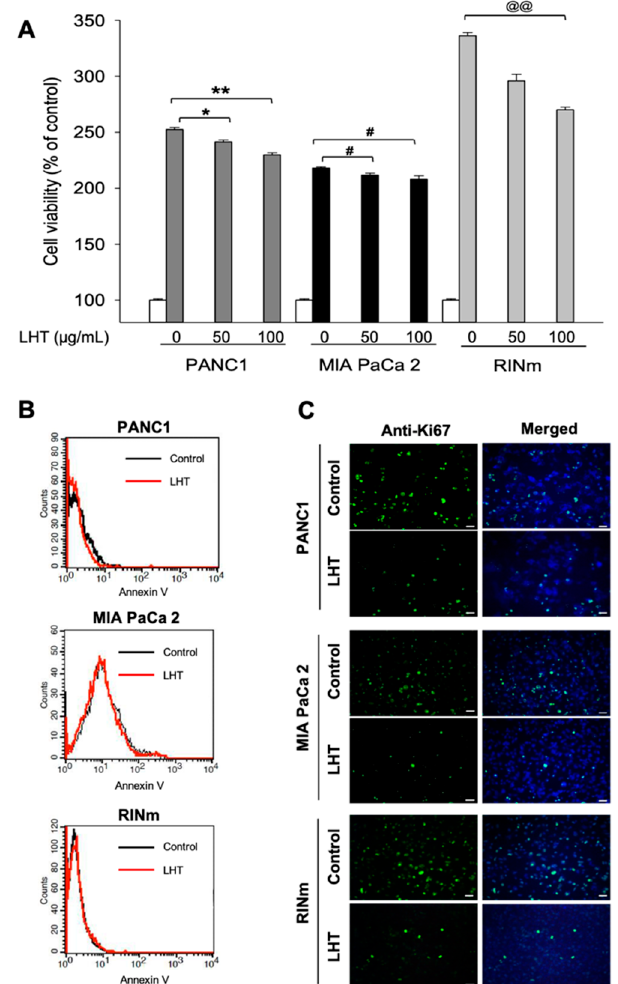
Figure 1. Proliferation inhibition of different types of pancreatic cancer cells after cultivation with LHT. ( A ) The viability of PANC1, MIA PaCa-2, and RINm cells after treatment of different concentrations (0, 50, 100 µg/mL) of LHT for 48 h. Data were expressed with mean ± s.e.m. (n = 8). White bar (control): the viability of each cells at seeding; Dark grey bar: PANC1 cell; Black bar: MIA PaCa-2 cell; Light grey bar: RINm cells. * p < 0.05, ** p < 0.01, # p < 0.05 and @@ p < 0.01 versus the control for each group. ( B ) Flow cytometry analysis using PE Annexin-V Apoptosis Detection Kits (triplicate) after treatment of LHT (100 µg/mL) for 48 h. ( C ) Anti-Ki67 immunostaining of pancreatic cancer cells after treatment of LHT (100 µg/mL) for 48 h. Green: Anti-Ki67. Blue: DAPI. Scale bars indicate 100 µm.